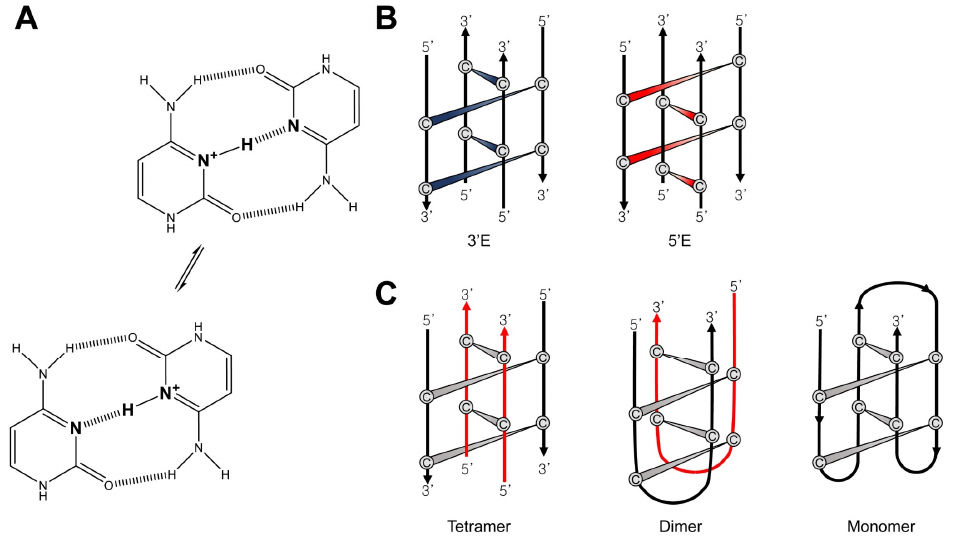
Figure 4. ( A ) Hemiprotonated C ⋅ C + base-pairs. ( B ) I-motif topologies (5 ′ E and 3 ′ E). ( C ) Oligomeric states of i-motifs.